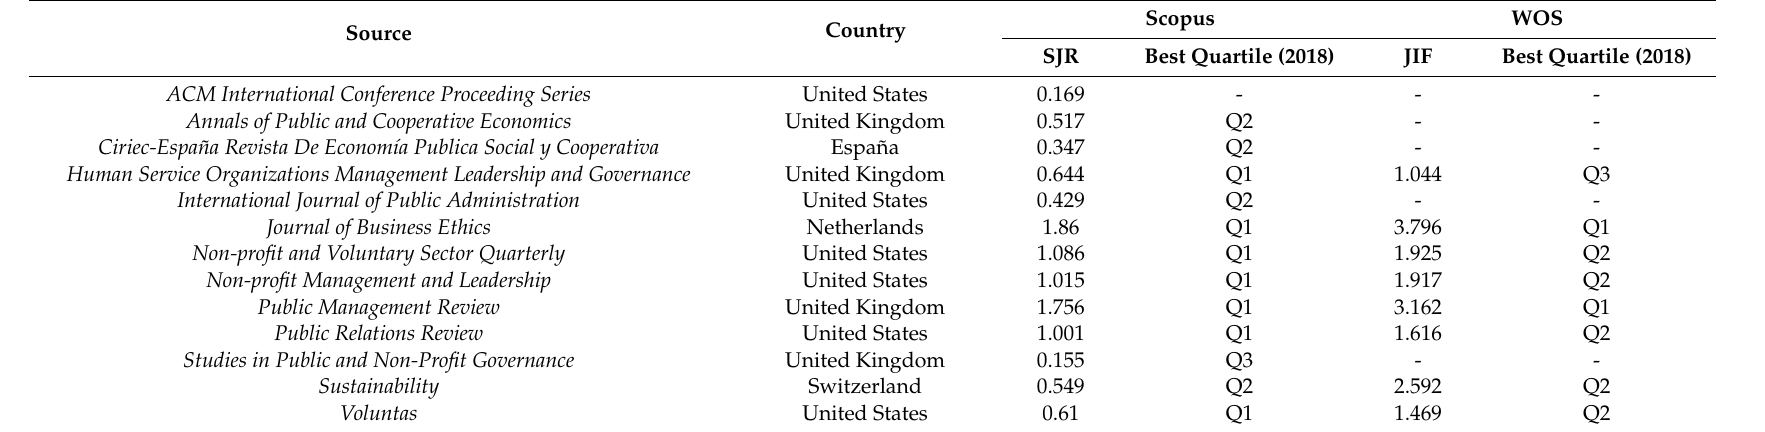
Table 1. Top of journals on publications on social innovation and non-profit